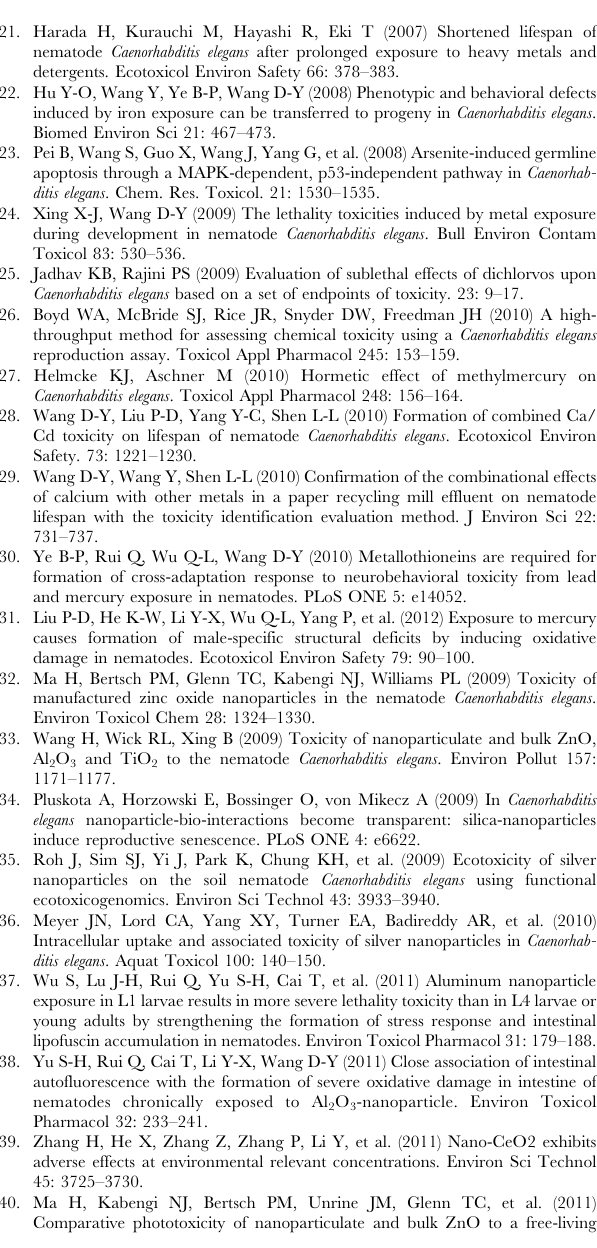
Table S1 Associations of ROS production with lethality, growth, reproduction, locomotion behavior, metabo- lism, and intestinal autofluorescence in nematodes exposed to DMSA coated Fe 2 O 3 -NPs as assayed by linear regression analysis.